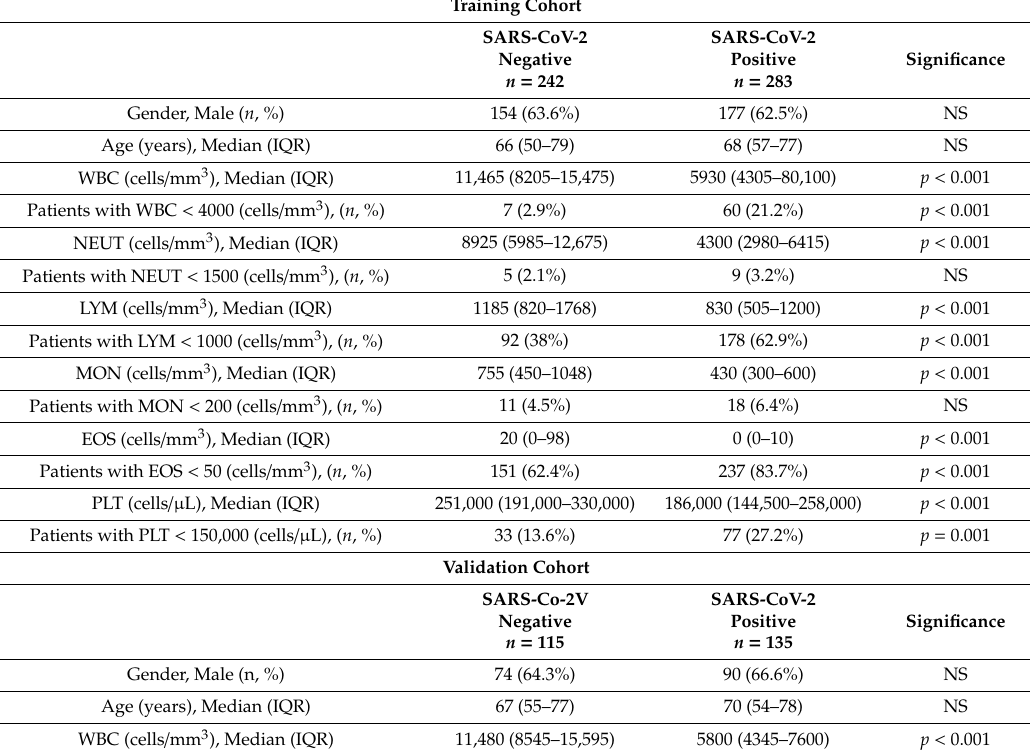
Table 2. Intracohort di ff erences in demographics and laboratory